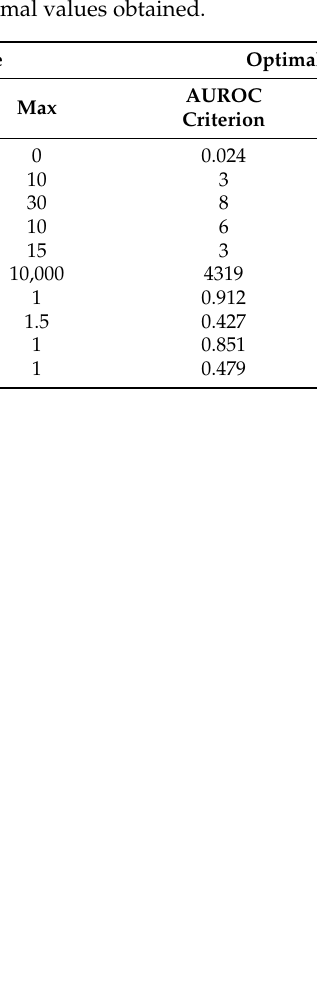
Figure 3. Pipeline of the model hyperparameters